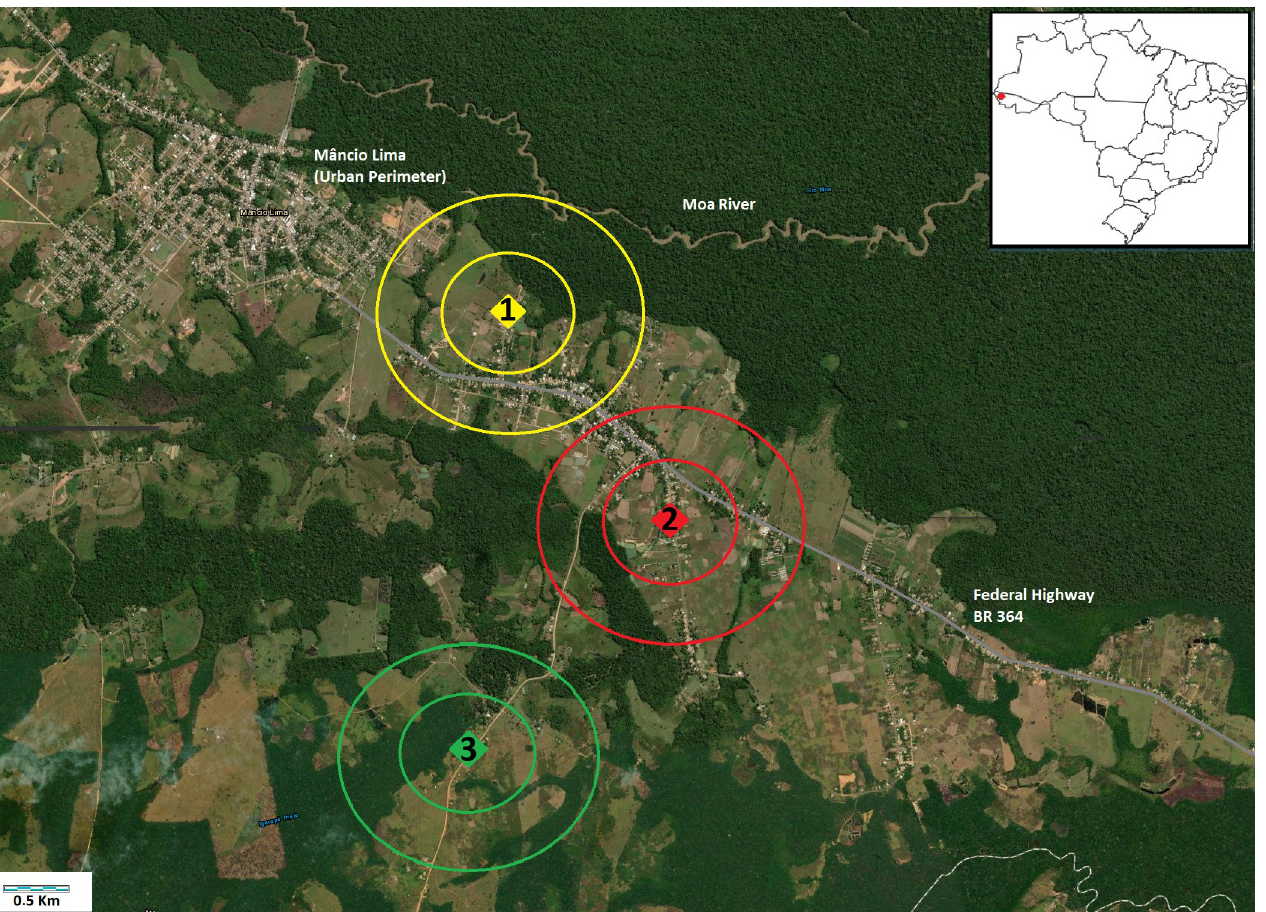
Fig 1. Satellite image of Maˆncio Lima municipality, showing the three study sites. Site 1, urban, yellow, near Federal Highway BR 364 and Maˆncio Lima town; Site 2, urban, red, near Federal Highway BR 364 and more distant from Maˆncio Lima; Site 3, rural, green, distant from both BR 364 and Maˆncio Lima. Each site shows the residence at center, and the two perimeters: 0.5 and 1.0 km. The insert is a map of Brazil indicating the location of Mancio Lima in Acre state. Content is the intellectual property of Esri and is used herein with permission. Copyright © 2021 Esri and its licensors. All rights